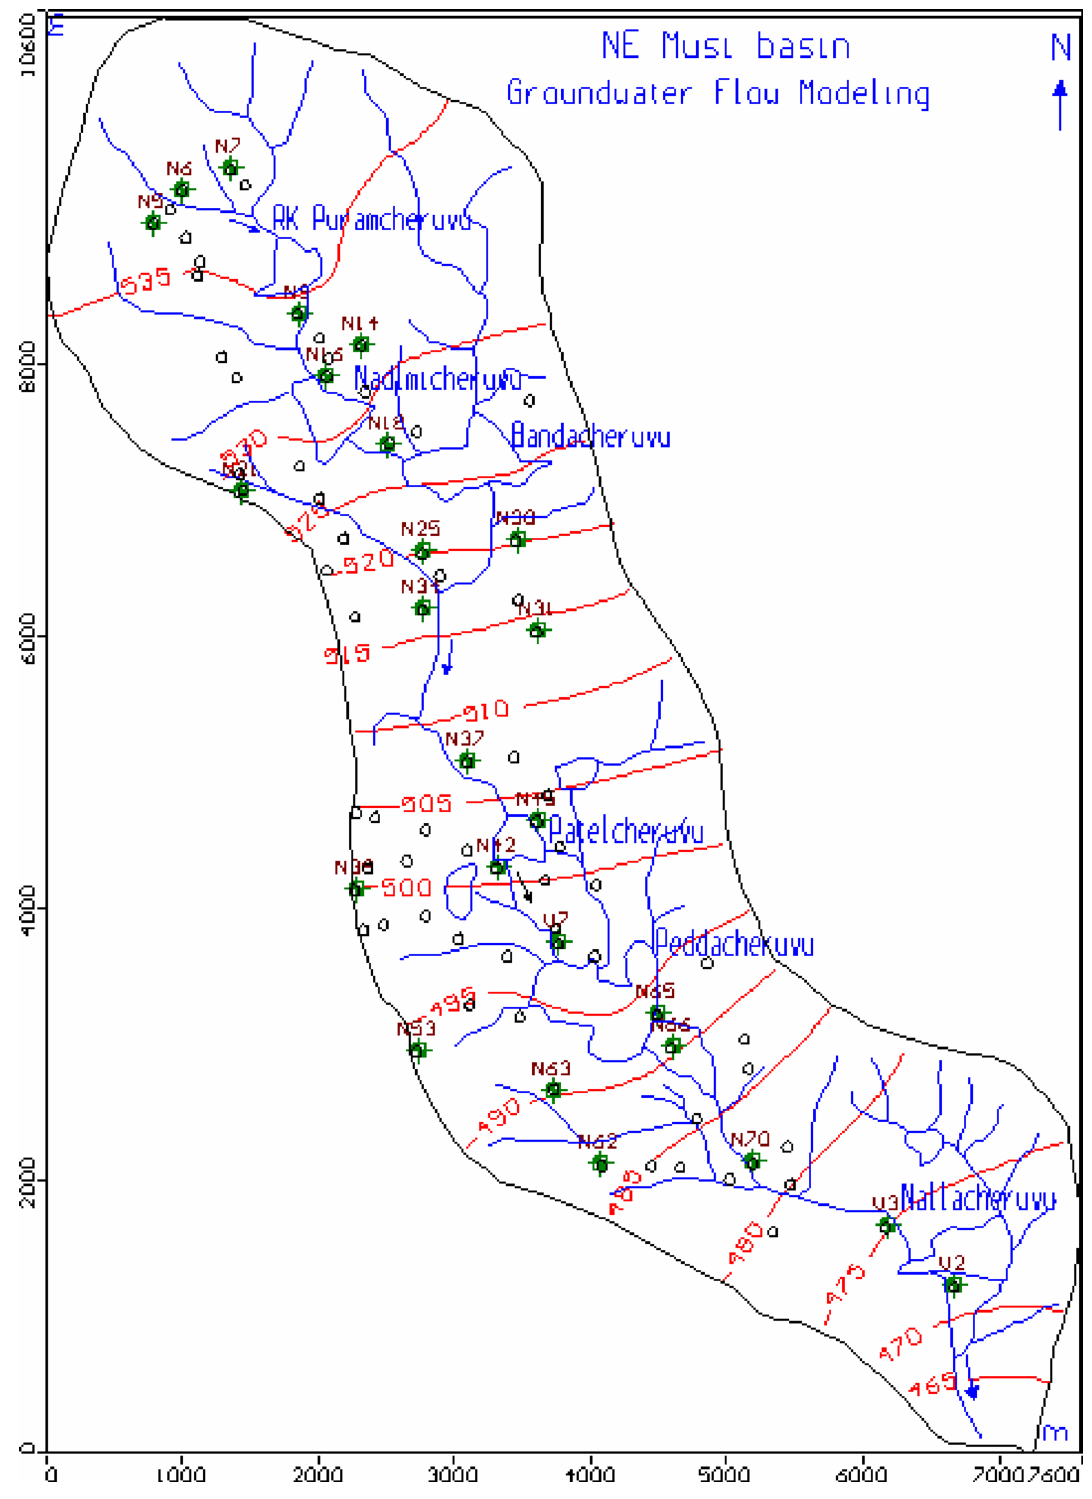
Fig. 8 Computed water levels of June